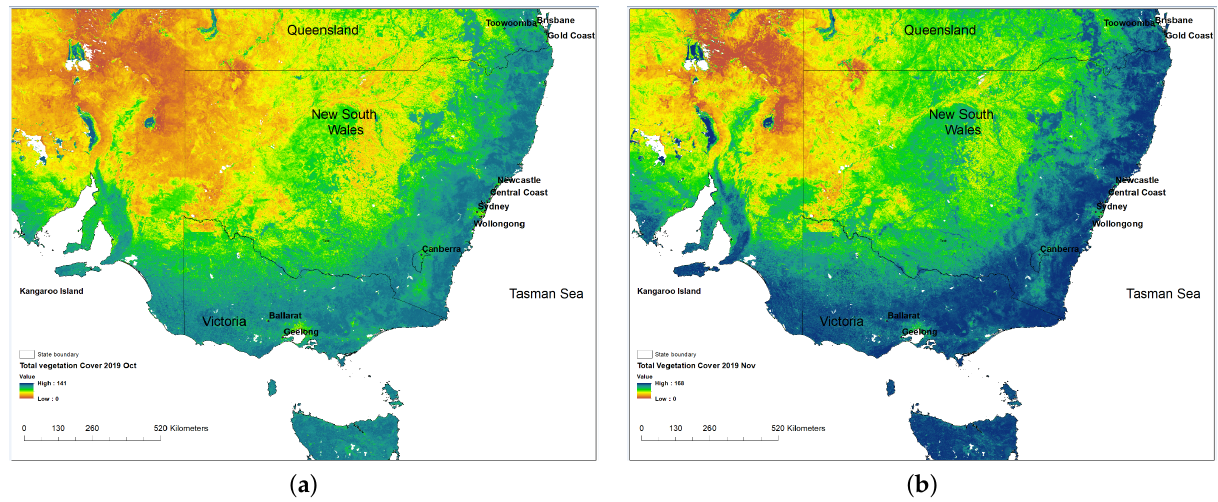
Figure 1. Vegetation cover over southeastern Australia in October ( a ) and November 2019 ( b ) (source: Australia monthly cover. Available online: http://www-data.wron.csiro.au/remotesensing/MODIS/products/public/v310/australia/ monthly/cover/, accessed on 27 March 2021). In November, the rain alleviated the drought condition in midwestern NSW and promoted the green growth with increased vegetation cover along the coast of NSW and